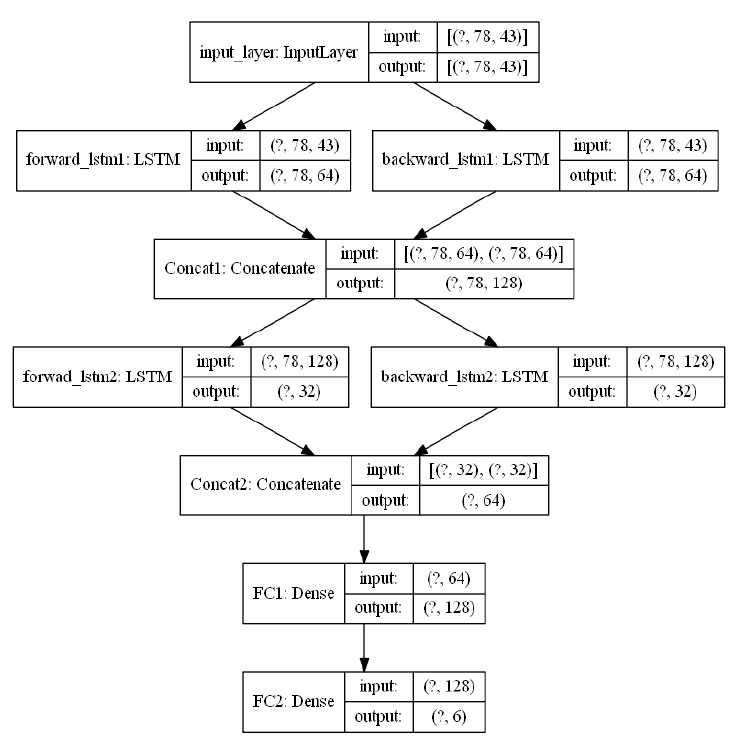
Figure 6. Proposed emotion recognition network structure.